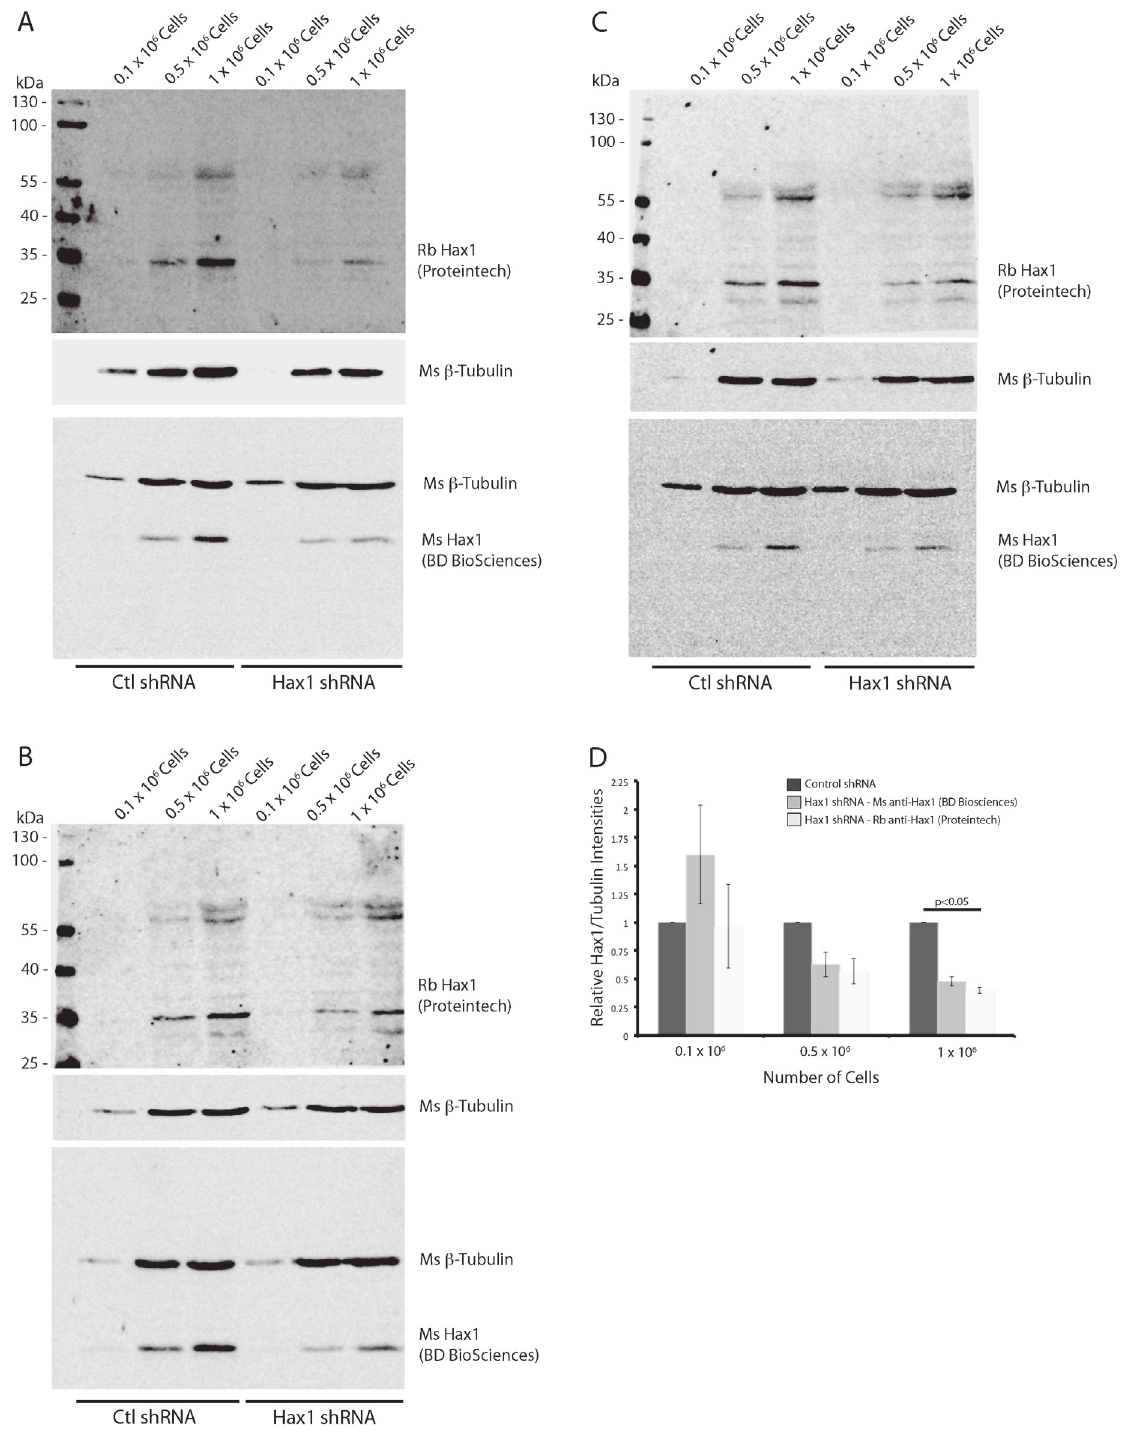
Figure 4. Detection of Hax1 in Control shRNA and Hax1 shRNA expressing differentiated PLB-985 cells using mouse and rabbit anti- Hax1 antibodies. ( A – C ) Western blot analysis of differentiated PLB-985 cell lysates from 0.1 × 10 6 , 0.5 × 10 6 , and 1 × 10 6 cells expressing either control shRNA or Hax1 shRNA from three independent replicates. Mouse anti-tubulin (beta-) is used as a loading control and can be seen present at a relative mobility of 55 kDa. Both mouse and rabbit anti-Hax1 detects a band at a relative mobility of 35 kDa as predicted. ( D ) Quantification of the band intensities of tubulin and Hax1 relative to control shRNA from three independent Western blots. Error bars indicate standard error of the mean. p values were calculated using paired t-test to assess significance relative to control shRNA.